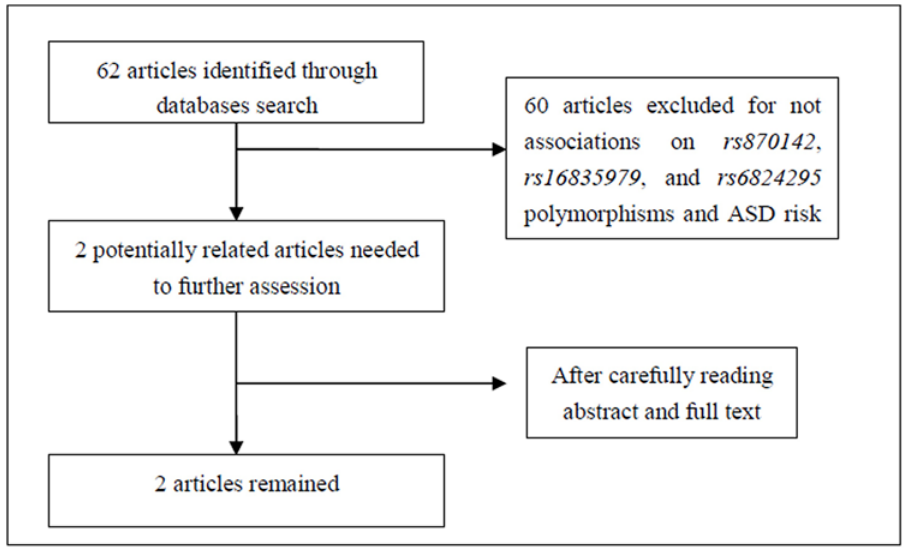
Fig 1. Specific screening flow diagram of articles in